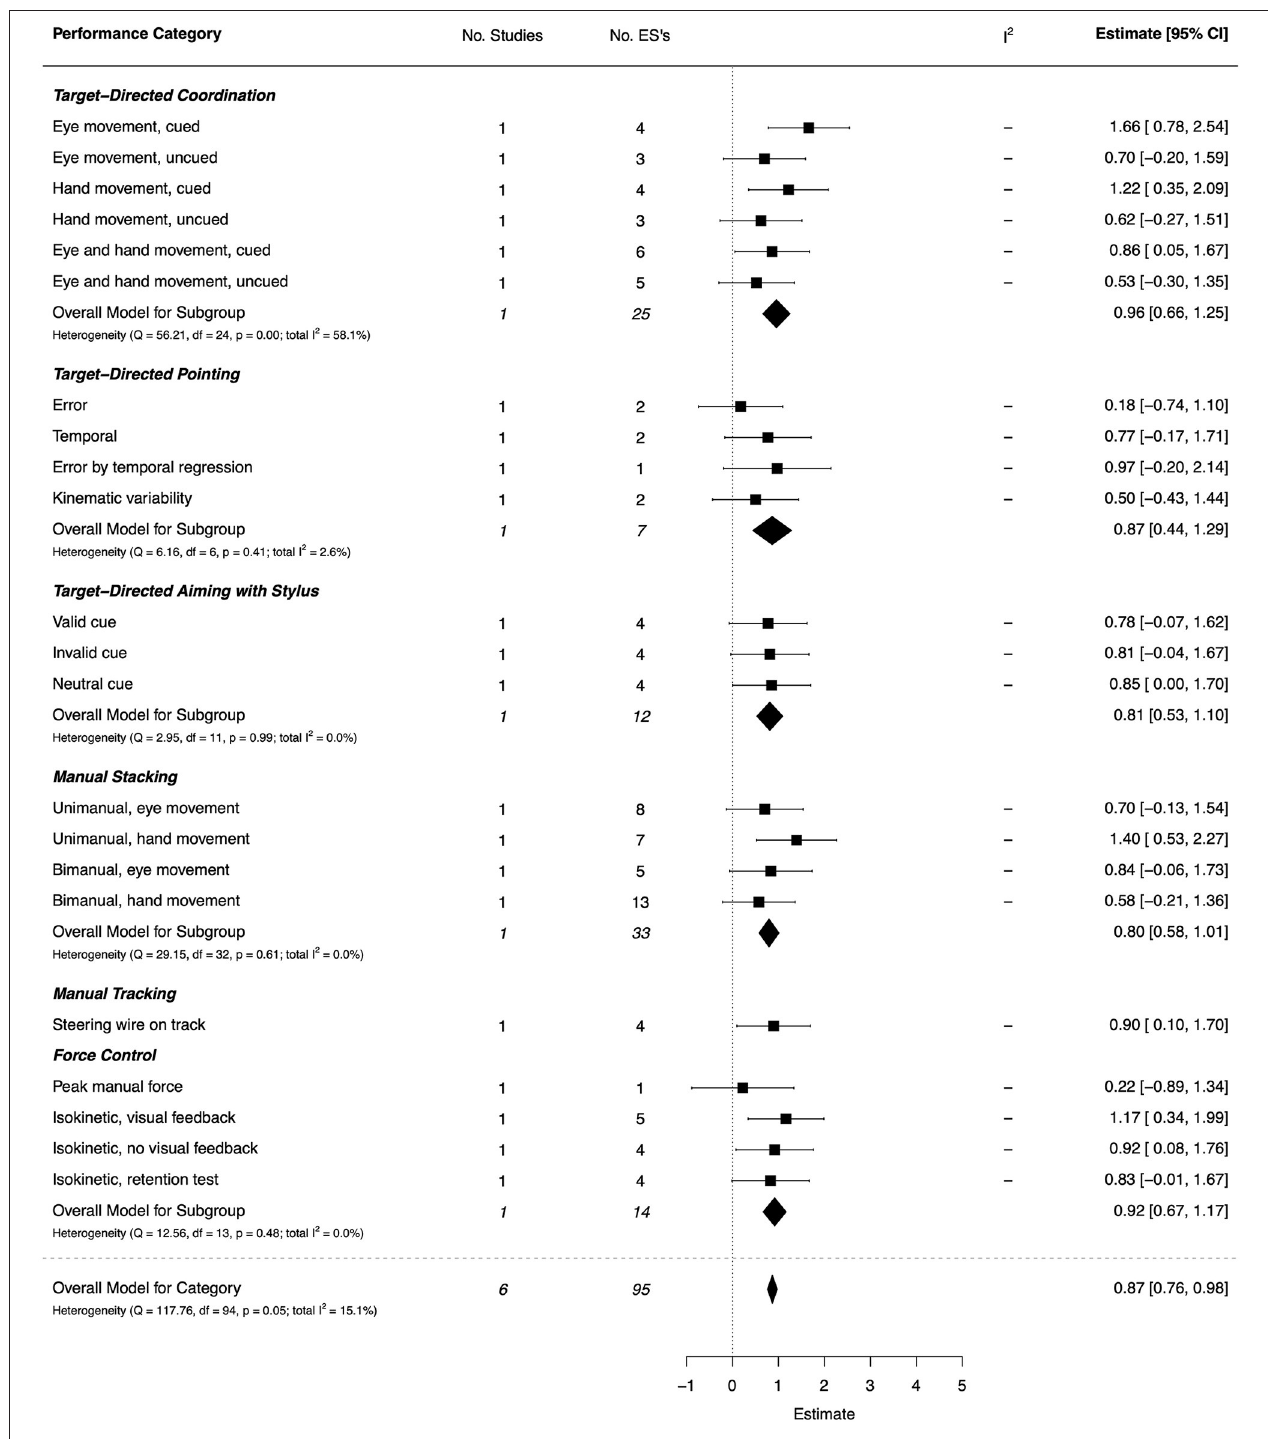
FIGURE 8 | Forest plot showing the meta-analysis results for the reaching and manual control performance category.